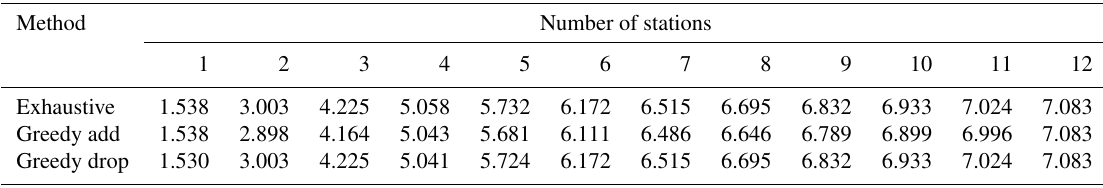
Table 6. Resulting joint entropy for the artificially permuted dataset with 860 data points. Method